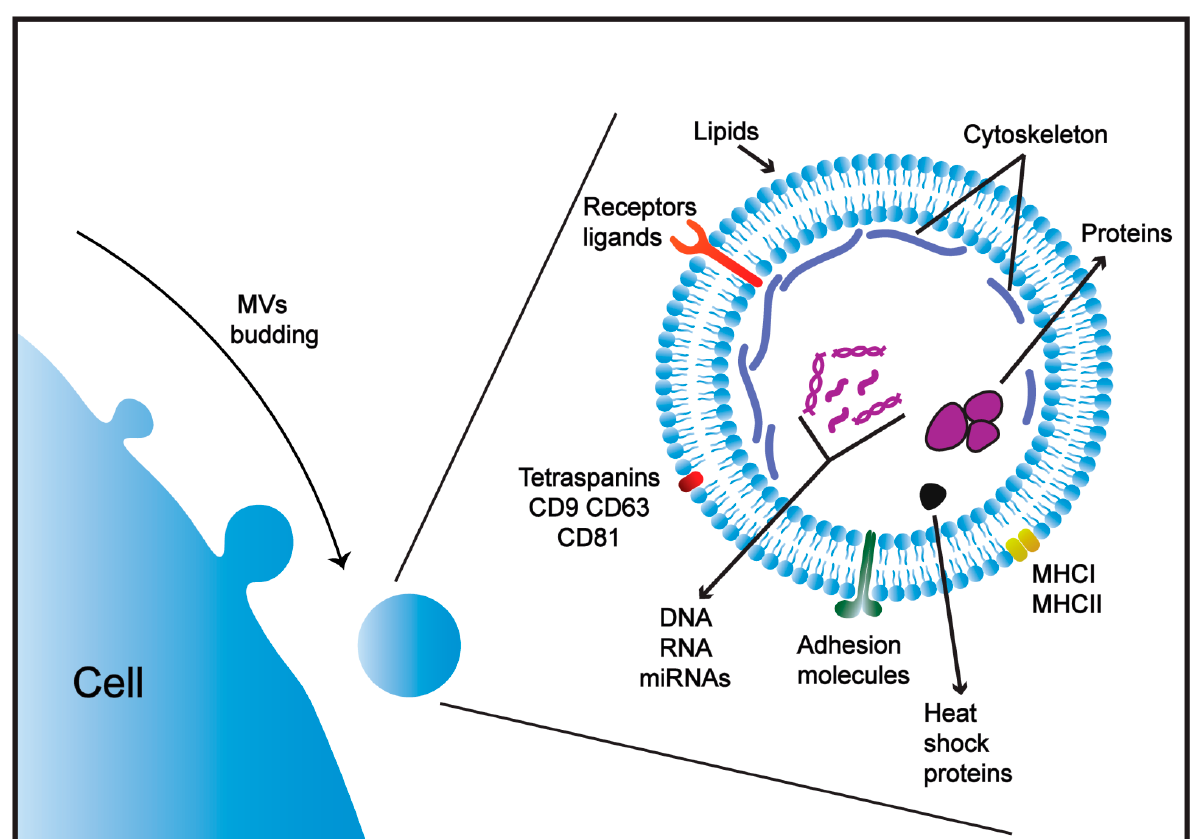
Figure 1. Structure of microvesicles (MVs). MVs consist of a phospholipid membrane bi-layer and contain transmembrane proteins (ligands and receptors), adhesion molecules and common markers including major histocompatibility complexes (MHC), and heat shock 70-kDa proteins. MVs are enriched with tetraspanins and cytoskeletal proteins and possess a set of proteins and nucleic acids unique to the cell of origin.